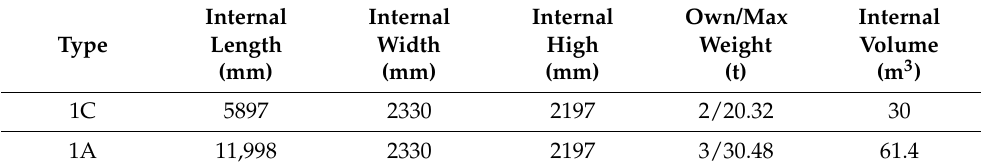
Table 10. Parameters of containers.